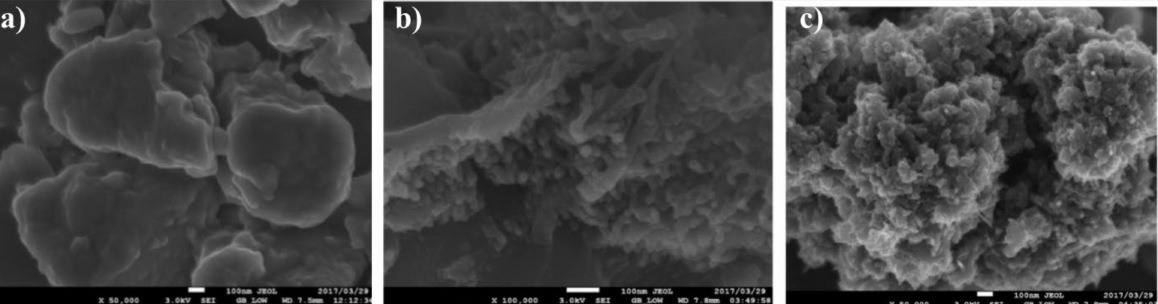
Figure 5. SEM images for nanocarbons carbonized at 400 ◦ C for different time intervals ( a ) 2 h, ( b ) 3 h, and ( c ) 4 h. Adapted with permission from Ref. [105].